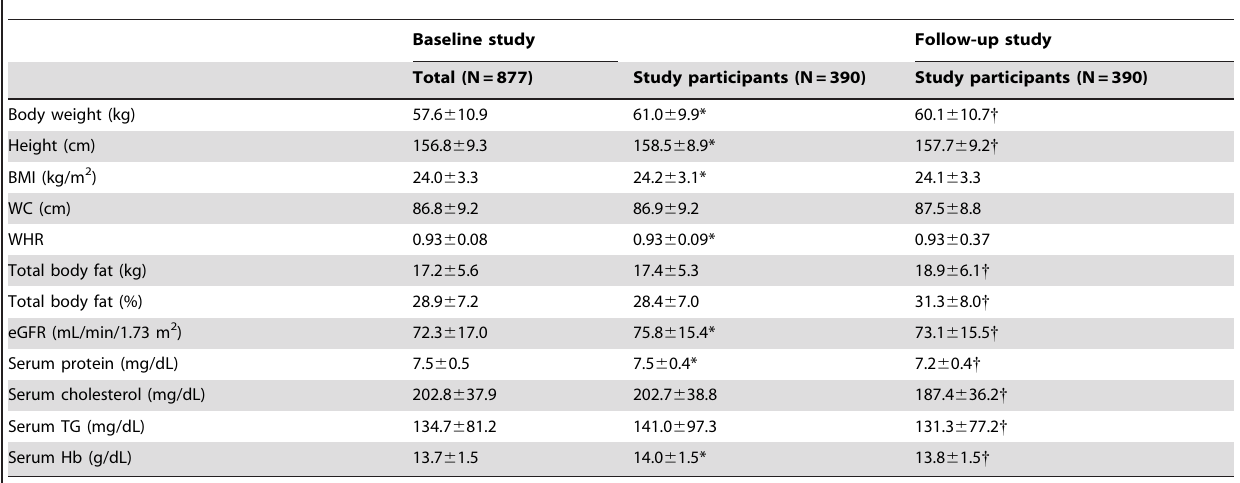
Table 1. Findings for physical and nutritional parameters at baseline and